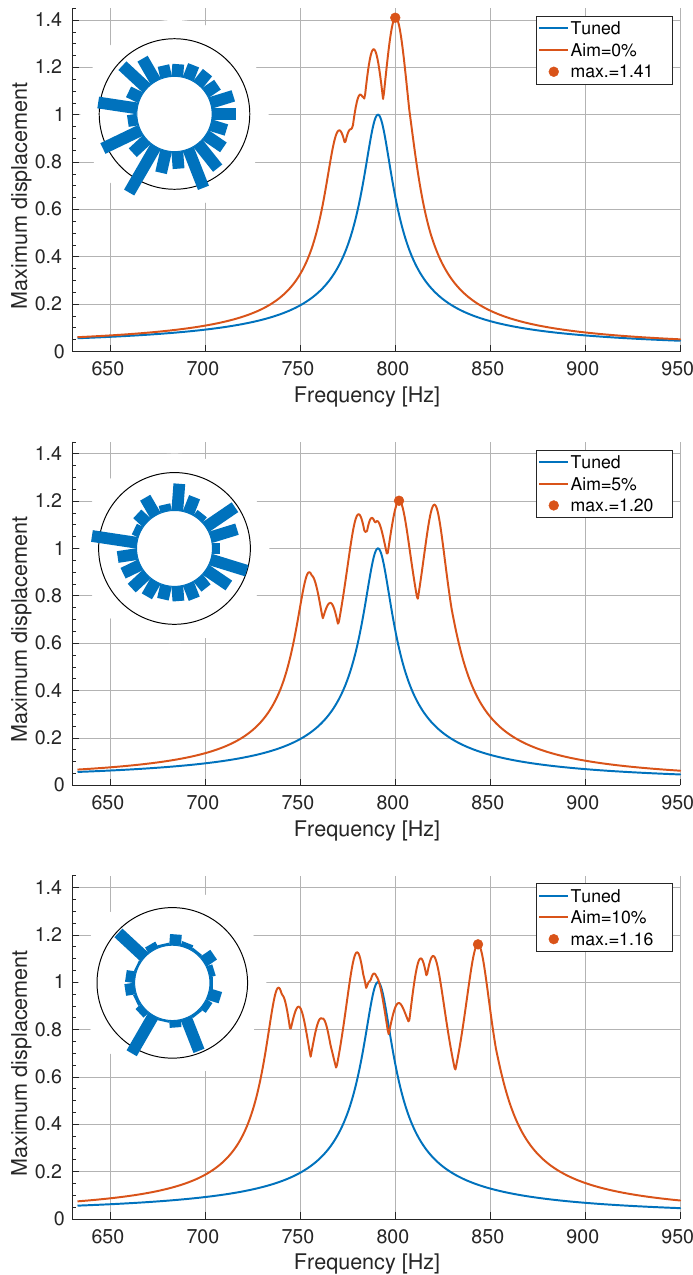
Figure 14. Frequency sweep and (inset) blade displacement at the maximum (black line corresponds to the tuned amplitude), for Aim = 0% ( top ), Aim = 5% ( middle ), and Aim = 10% ( bottom ). Rotor B, [ 1,0, − 1, . . . ,1,0, − 1 ] pattern, ξ = 10 − 2